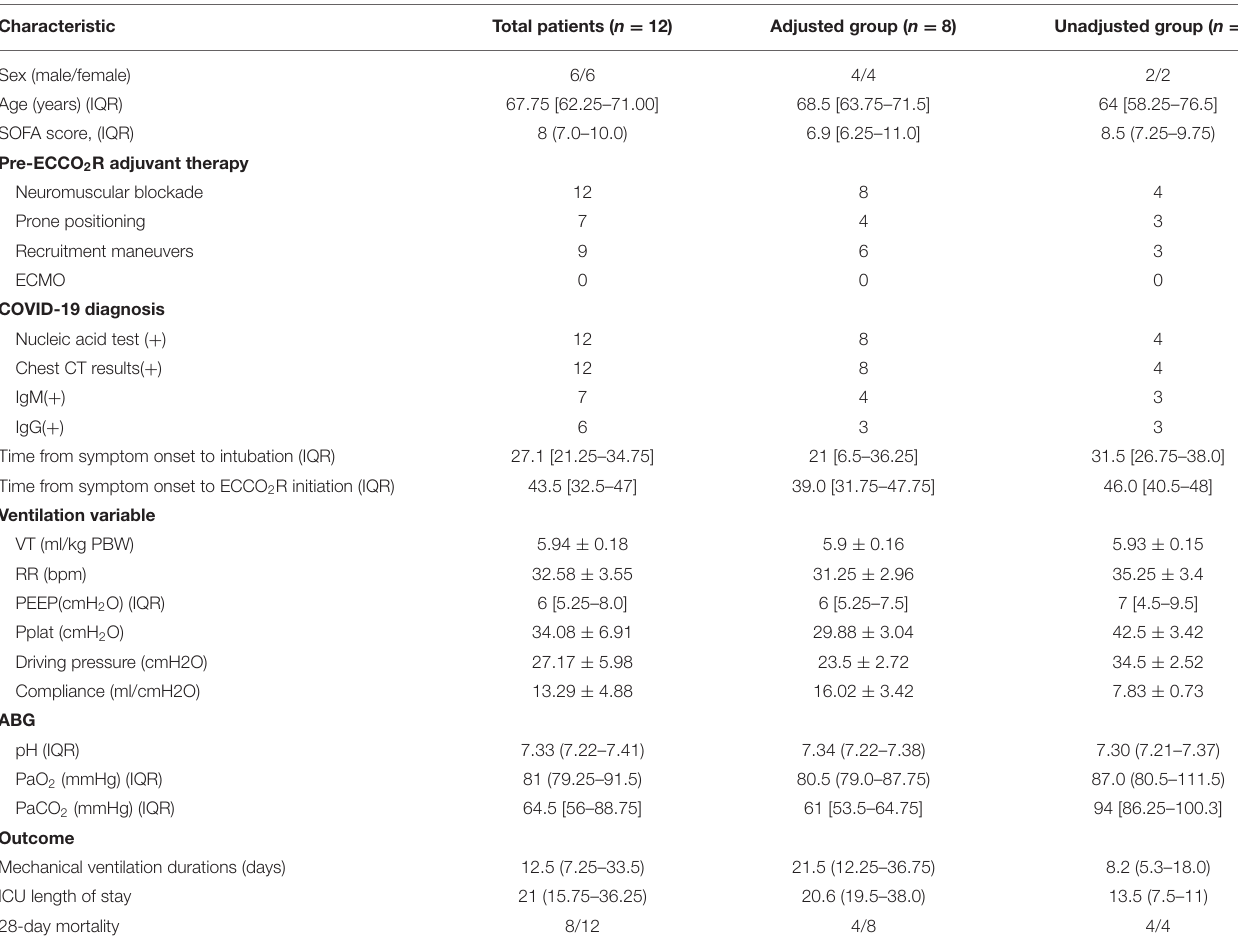
TABLE 1 | Baseline